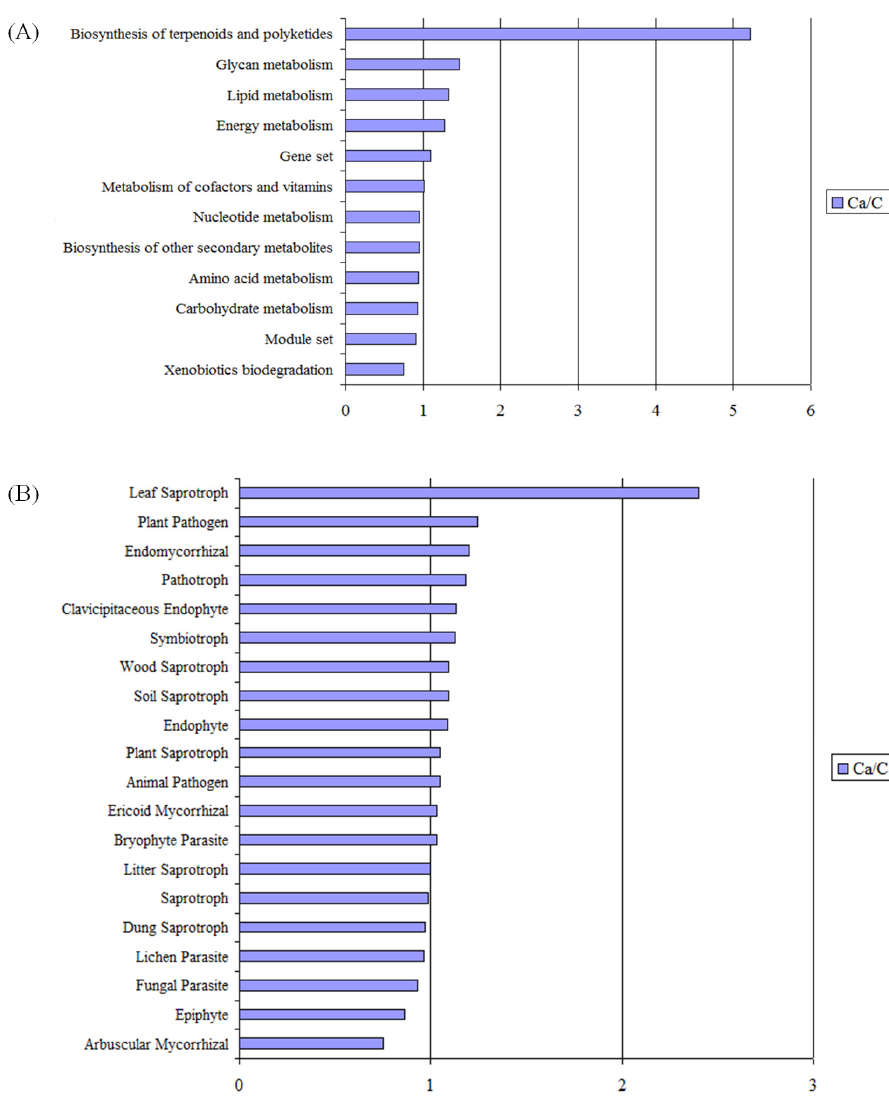
Figure 7. The bacterial ( A ) and fungal ( B ) functional features are based on the bacterial functions predicted by the KEGG module and the fungal functions potential estimated by the FUNGuild tool. The horizontal bars express the feature ratio value of the compost-amended soils (Ca) to una- mended control soils (C).